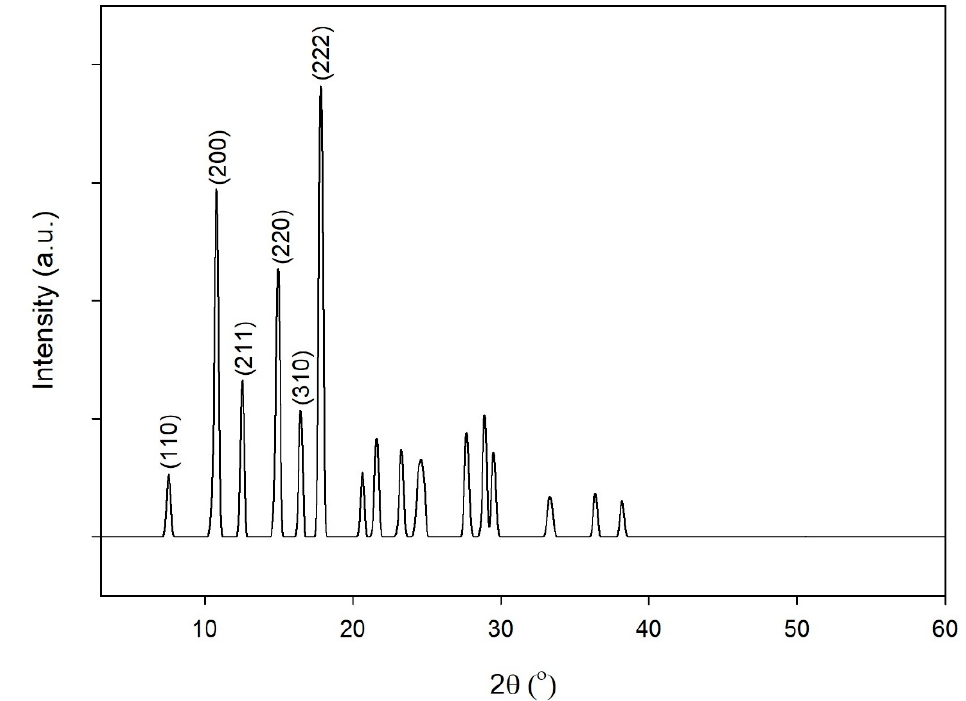
Figure 8. XRD spectra of ZIF-L.